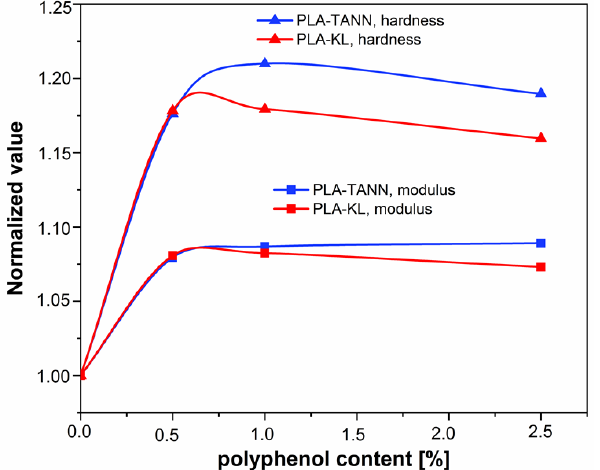
Figure 8. Normalized properties of neat material values of nanoindentation modulus and hardness are plotted in dependence on concentration of added polyphenols.